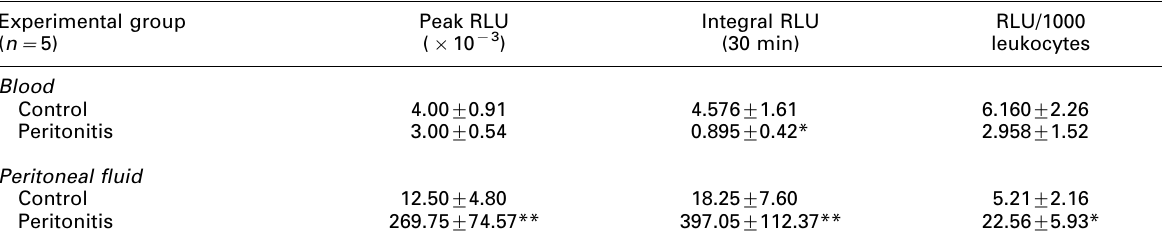
Table 2. Phagocytic activity of leukocytes in blood and peritoneal fluid, measured by zymosan-induced luminol-dependent chemiluminescence response Experimental group (n (cid:5) /